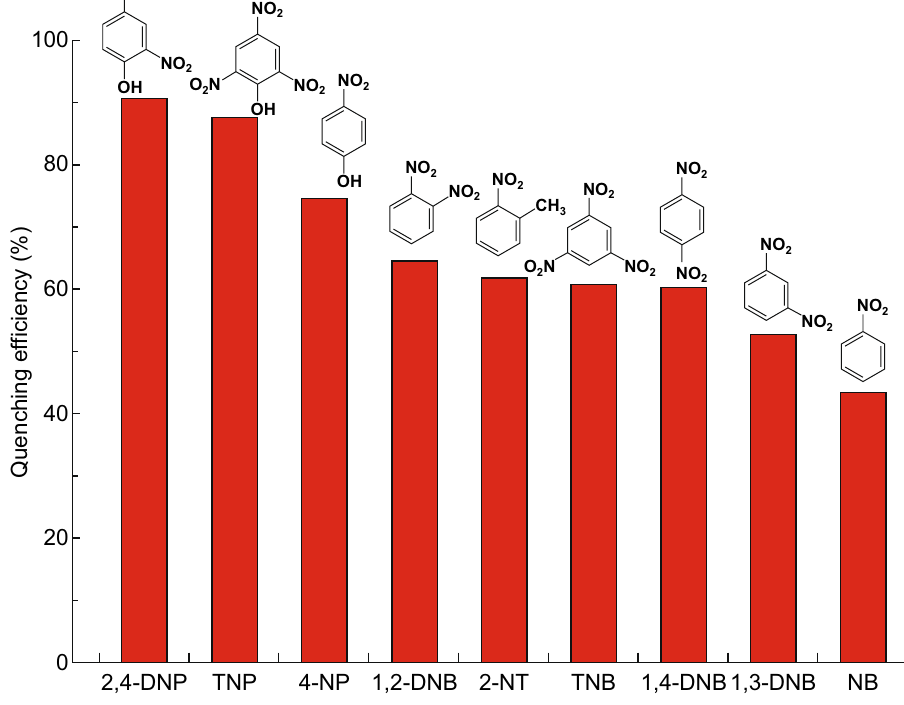
Fig. 13 The quenching percentage of [Zn(H 2 L)(2,2-bipy)] n in DMF of NB, 2-NP, 4-NP, 1,2-DNB, 1,3-DNB, 1,4-DNB, 2,4-DNP, TNP and TNB at excitation of 278 nm. Reprinted with permission from Ref. [47]. Copyright 2019, Royal Society of